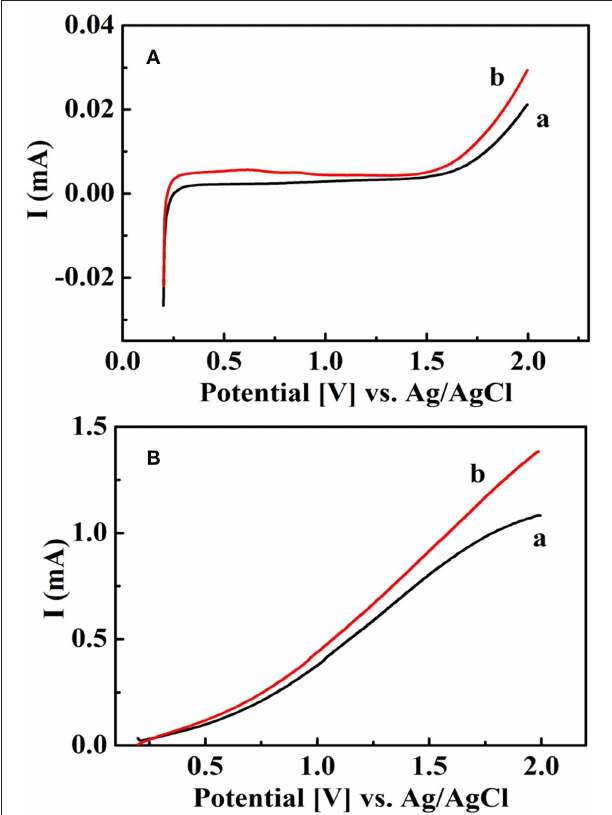
FIGURE 4 | Linear voltammograms of the sensing system: (a) 0.2mM Na 2 SO 4 and (b) 0.2mM Na 2 SO 4 containing glucose organic using 3D Au-NPs/TNTAs sensing electrode at the potential scan rate of 10 mVs − 1 without (A) and with (B) UV